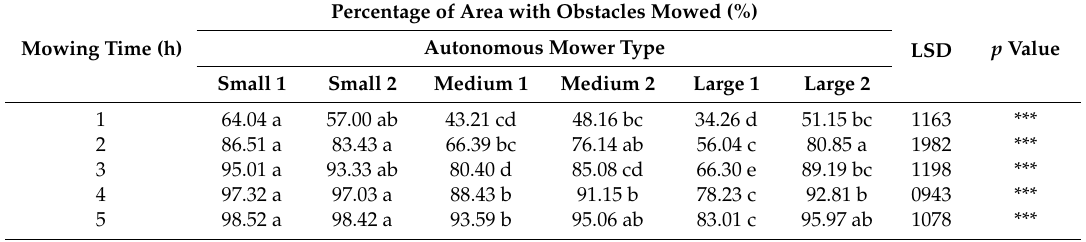
Table 3. Back-transformed mean values of the percentage of area with obstacles within Site B mowed after 1–5 h by the six di ff erent autonomous mowers.